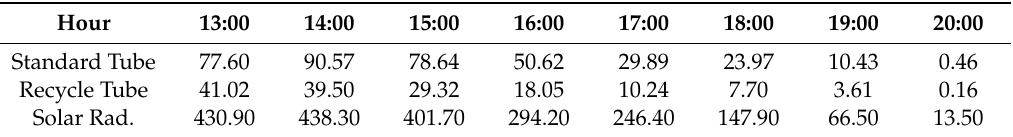
Table 5. Values obtained from the analysis of the luminosity in the test environments and in the meteorological station—Part 2.